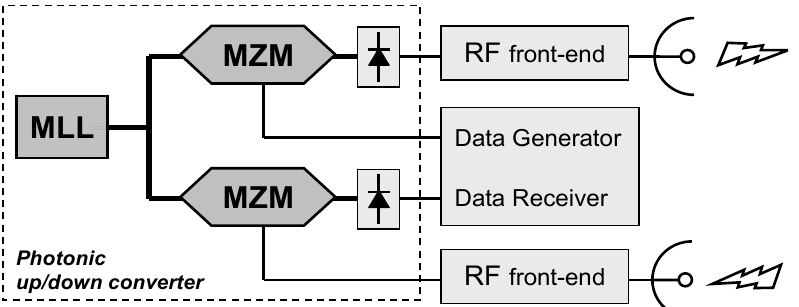
Figure 1. Scheme of principle of the transceiver. MLL: Mode-locked laser; MZM: Mach-Zehnder